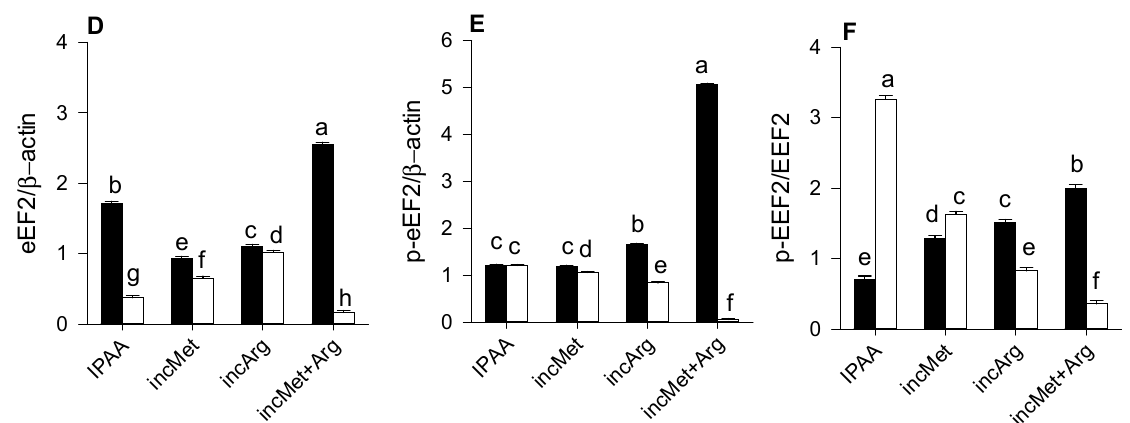
Figure 2. Protein abundance (relative to β -actin) of mTOR (total, panel A ), p-mTOR (active, panel B ), ratio of p- mTOR/mTOR (panel C ) eEF2 (total, panel D ), p-eEF2 (active, panel E ), and ratio of p-eEF2/eEF2 (panel F ) in subcutaneous adipose tissue cultured with different levels of Met or Arg and stimulated with ceramide. Control media contained an ideal AA profile (IPAA) with ratios of Lys:Met 2.9:1 and Lys:Arg 2:1. Treatment media were supplemented with greater amounts of Met or Arg to achieve ratios of Lys:Met 2.5:1 and Lys:Arg 2:1 (incMet), Lys:Met 2.9:1 and Lys:Arg 1:1 (incArg), or Lys:Met 2.5:1 and Lys:Arg 1:1 (incMet + Arg). Different lowercase letters indicate differences between treatments (Met × Arg × Ceramide p < 0.05). mTOR = mechanistic target of rapamycin; eEF2 = eukaryotic elongation factor 2. Data are LS means, n = 4 cows per group, ± pooled SEMs.